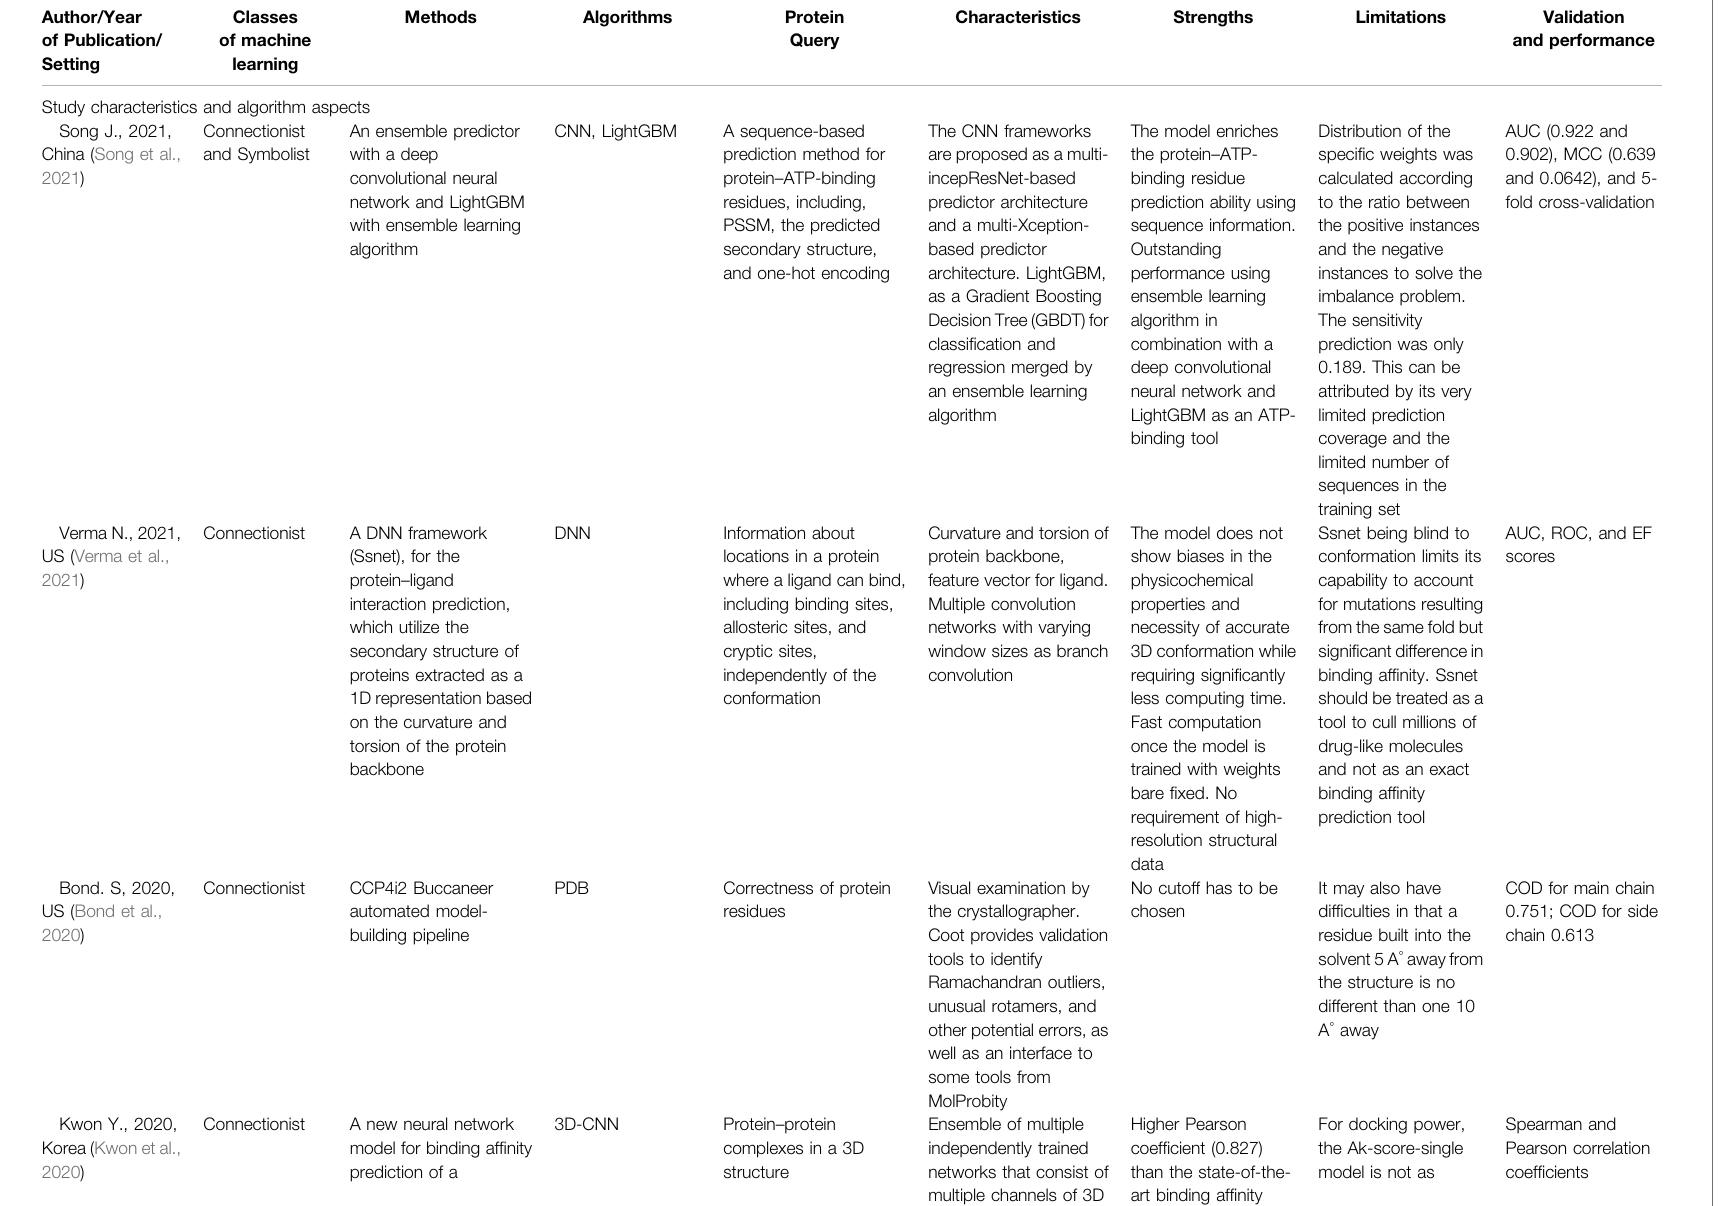
TABLE 1 | An overview of the included articles on study and algorithm features based in their characteristics, strengths, limitations, and measure of